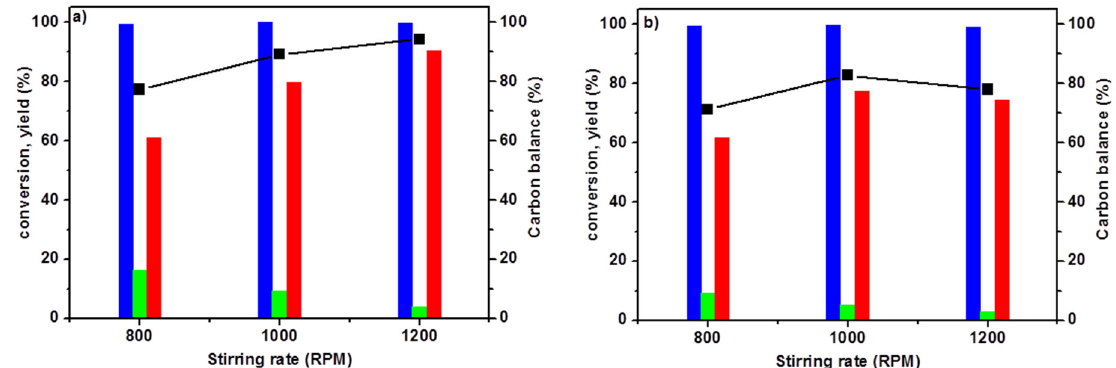
Figure 4. Effect of stirring rate on conversion and yield to products in the presence of ( a ) Au/AC_PVA and ( b ) Au/AC_PVP catalysts: ( ■ ) HDO conversion, ( ■ ) AA yield, ( ■ ) HHA Yield, ( ■ ) Carbon balance. Reaction conditions: HDO 42 mmol L − 1 , 20 mL H 2 O, nHDO/nAu =250, 110 °C, 15 bar air, 4 h, stabilizer/Au weight ratio of 1.2.